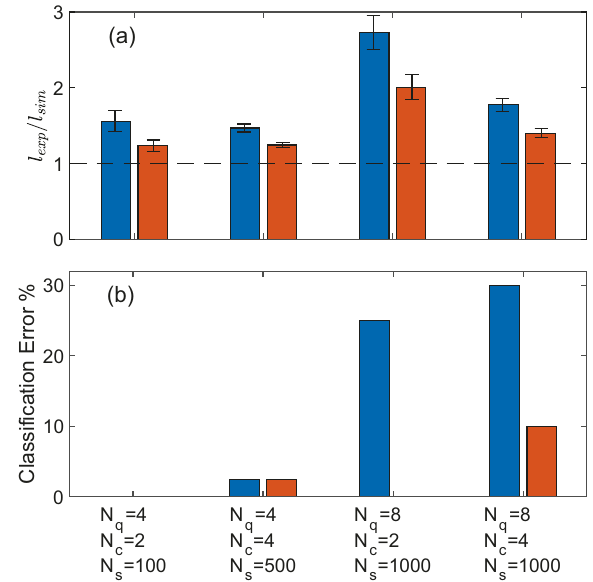
Fig. 3 Synthetic data. a Ratio of distance calculated from the quantum computer vs the simulator, and b classi fi cation of synthetic data for different number of clusters ( N c ), qubits ( N q ) and shots ( N s ) before (blue, left) and after error mitigation (red, right). The number of data points was 10 per cluster. The classi fi cation error is calculated by comparing the quantum to the classical labels for each dataset. For the synthetic data, our goal was to see whether the quantum Nearest Centroid algorithm can assign the same labels as the classical one, even though the points are quite close to each other. Thus our classical benchmark for the synthetic data is 0% classi fi cation error. The baseline which corresponds to the accuracy of just randomly guessing the labels is 1/ N c . The error bars in a correspond to the standard error in the ratio of distances for each